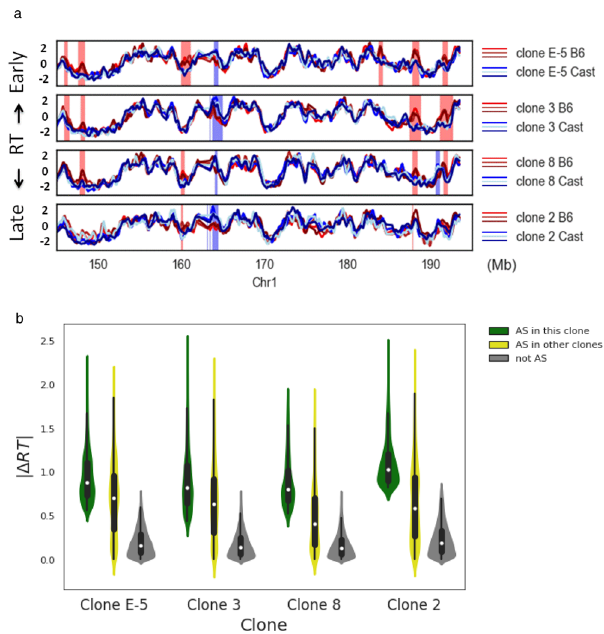
Fig. 2 Comparison of AS-RT in pre-B cell clones. a Replication timing (RT) of the B6 (red) and Cast (blue) alleles (three replicates) on Chr1 for different pre-B-cell clones. Asynchronous regions detected in each clone are marked by red (B6 early) or blue (Cast early) stripes. b Violin plots showing allelic replication-timing differences (| Δ RT|) for both the B6 and Cast early regions on all chromosomes for a given clone (green). This is compared to | Δ RT| in the same clone for asynchronous detected only in other clones (yellow) or for regions of the genome that were never detected as being asynchronous (grey). Each box shows the quartiles of the dataset while the whiskers extend to show the rest of the distribution, except for points that are determined to be outliers (>upper quartile + Iqr*1.5 or <lower quartile − Iqr*1.5). The number (n) of points included in each box ranged from 900 – 2000 for the AS loci and 13,000 – 22,000 for the non AS